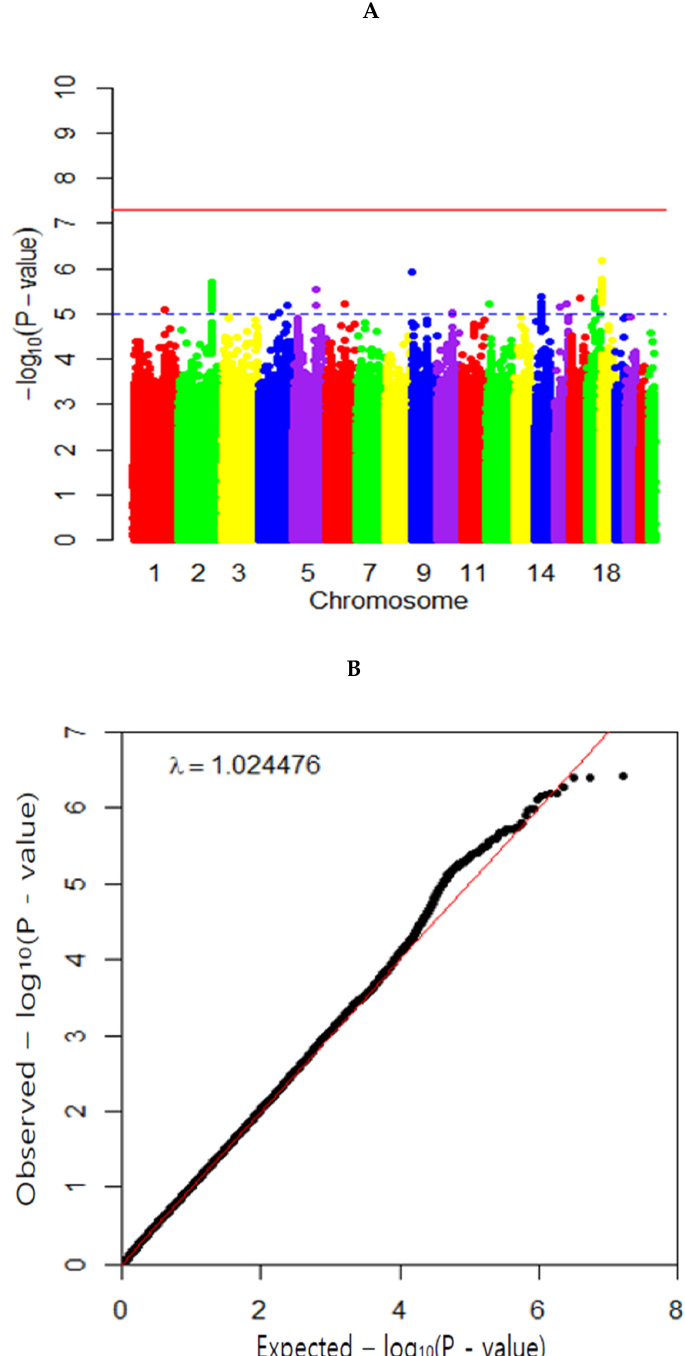
Figure 3. Distribution of genetic variants for dietary vitamin C estimated with genome-wide asso- ciation study. ( A ) Manhattan plot of the p -value of genetic variants for VC intake. ( B ) Q–Q plot of p -value based on the association analysis of VC intake.